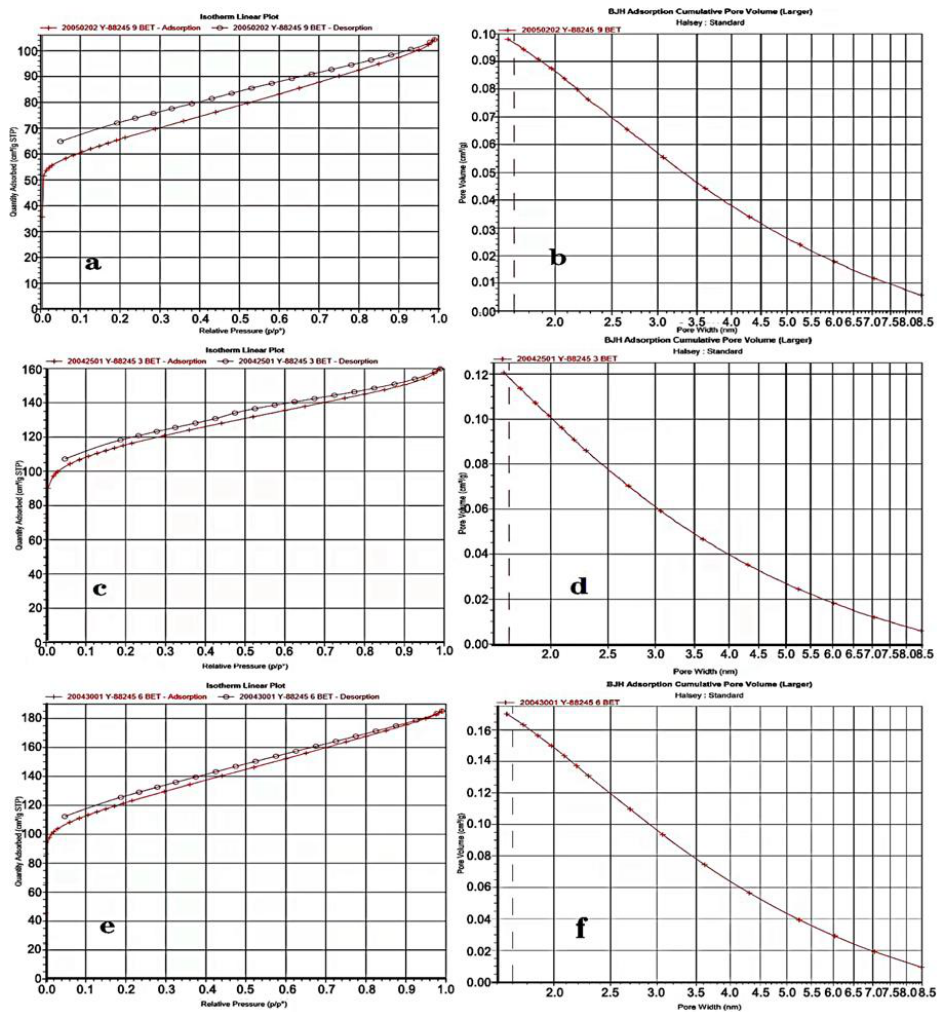
Figure 5. N 2 adsorption – desorption of ( a ) GBB650, ( c ) QBB650 and ( e ) SBB650; and pore size distri- bution of ( b ) GBB650, ( d ) QBB650 and ( f ) SBB650 prepared at preparation temperature T = 650 °C.